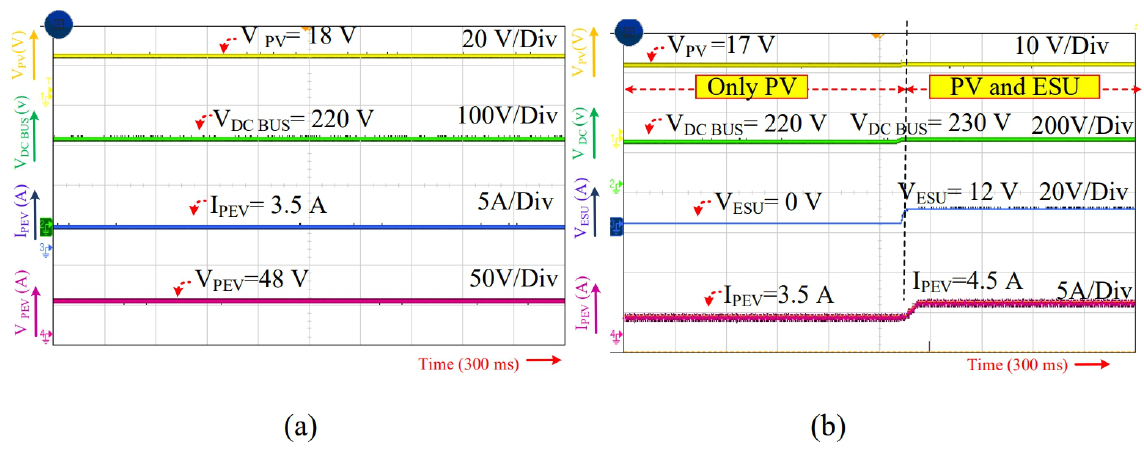
Fig. 9. Experimental Result: (a). PV to PEV mode, (b). different source.